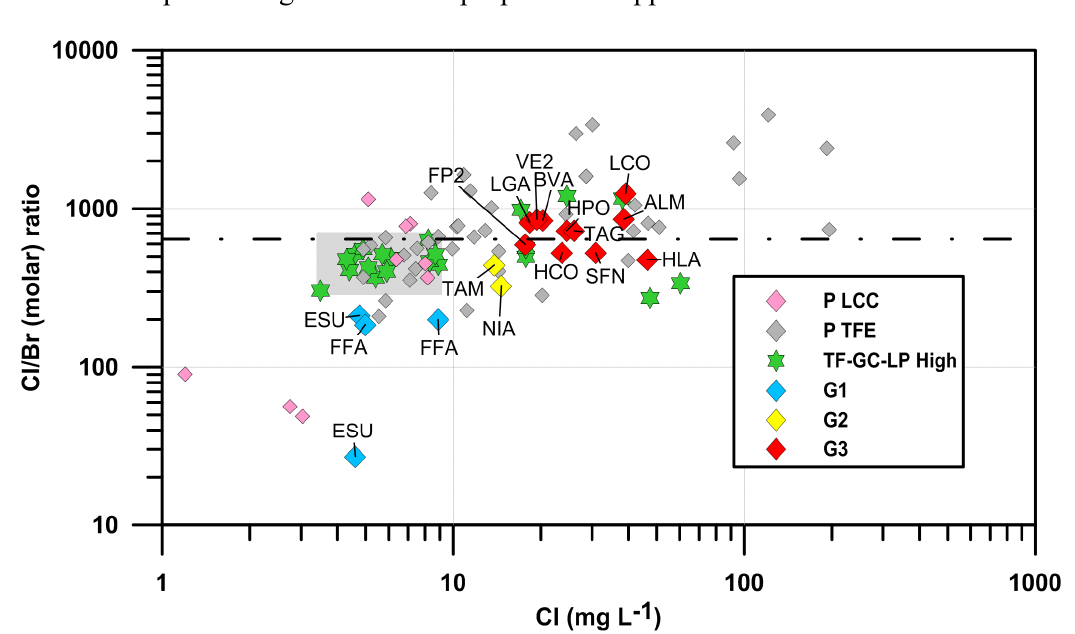
Figure 6. Plot of Cl (mg·L − 1 ) vs . Cl/Br molar ratio from different groups of samples studied. G1, recharge water; G2, shallow groundwater; and G3, deep groundwater as